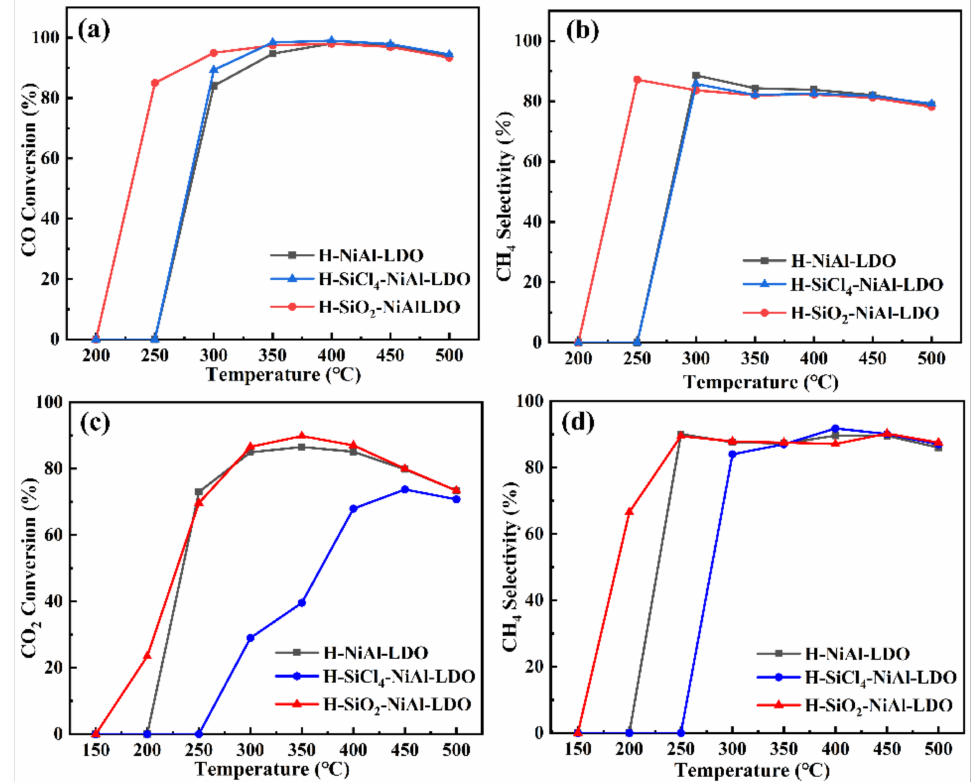
Figure 6. Catalytic performances of catalysts: ( a ) CO conversion, ( b ) CH 4 selectivity (CO); ( c ) CO 2 conversion, ( d ) CH 4 selectivity (CO 2 ).